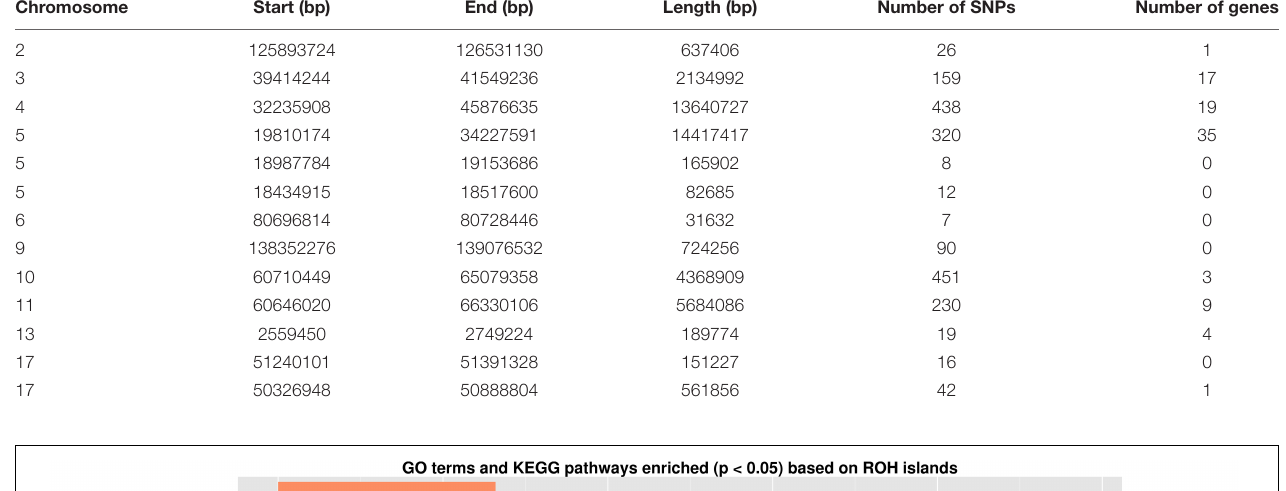
TABLE 4 | List of ROH islands observed in this Laiwu pig population. Chromosome